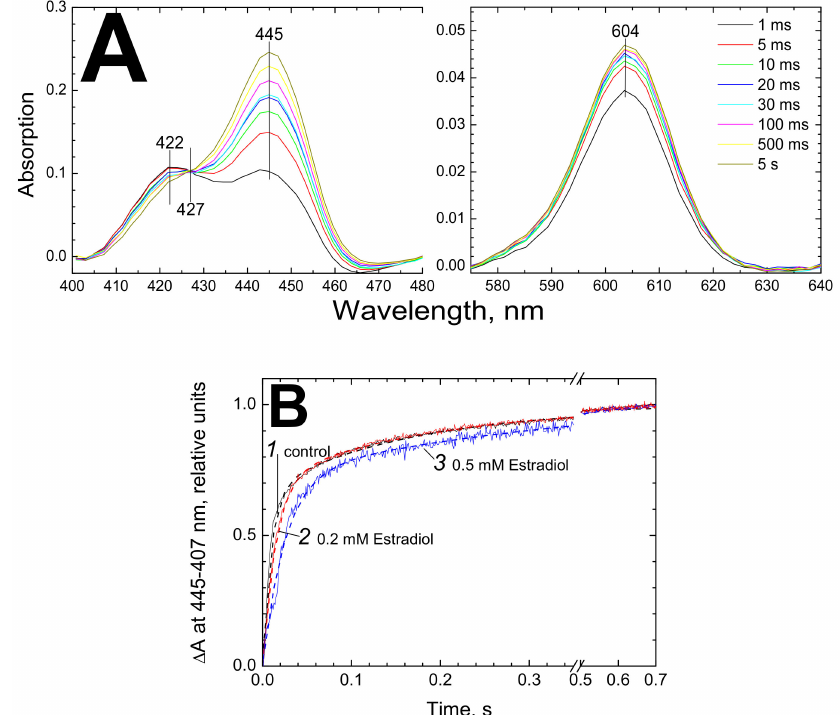
Figure 4. Estradiol inhibits reduction of heme a 3 . ( A ) Series of absolute spectra obtained upon rapid mixing of CcO with strong reductant using diode array spectrophotometer SX-20. Final concentrations: 3 µ M CcO, 20 mM sodium dithionite, 5 mM RuAm. The left and right panels represent the Soret and the visible regions of the spectra, respectively. ( B ) Kinetics of absorption di ff erence at (445 nm–407 nm) upon rapid reduction of the air-oxidized CcO is shown (see panel A for experimental conditions). Trace 1 (black)—control, trace 2 (red)—CcO was treated with 0.4 mM estradiol before mixing with the reductant, 3 (blue)—CcO was treated with 1 mM estradiol before the mixing. The experimental data are superimposed on the theoretical curves (dashed traces) described by the function: f(x) = A 1 · (1-exp(-x / τ 1 )) + A 2 · (1-exp(-x / τ 2 )), where A 1 , A 2 are normalized amplitudes and τ 1 , τ 2 are characteristic times of the rapid and slow phases, respectively (see the